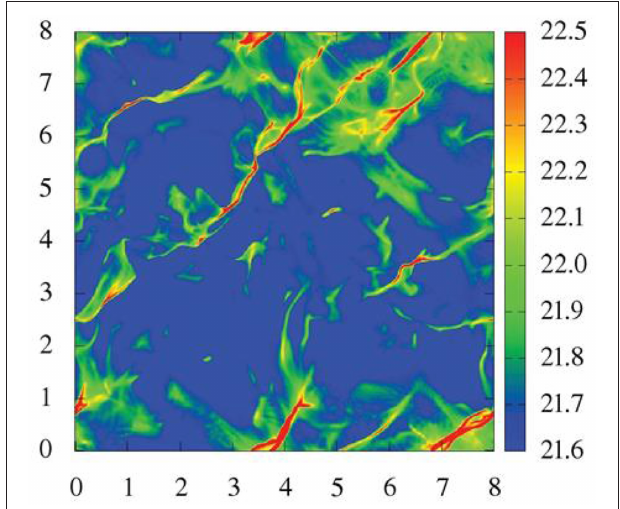
FIGURE 11 | Formation of supercritical filaments and striations (Inutsuka et al., 2015 ) in a shocked layer (seen face on). In this calculation the filaments are self-gravitating (and therefore named supercritical) and the striations are mainly perpendicular to the filaments. Reproduced from Inutsuka et al. (2015) with permission of